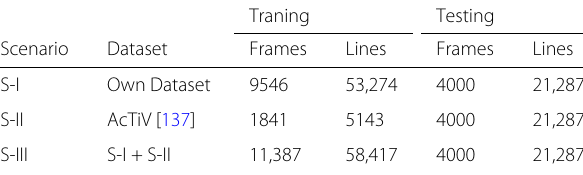
Table 2 Experimental scenarios for text